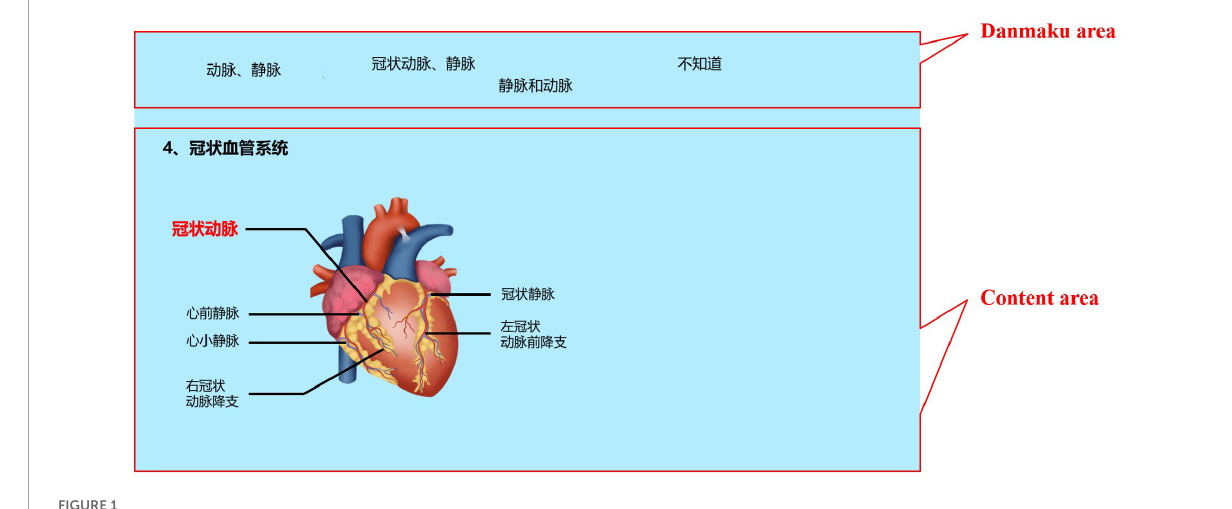
FIGURE1 Danmaku and video content positioning on instructional video screen in Dandan Play